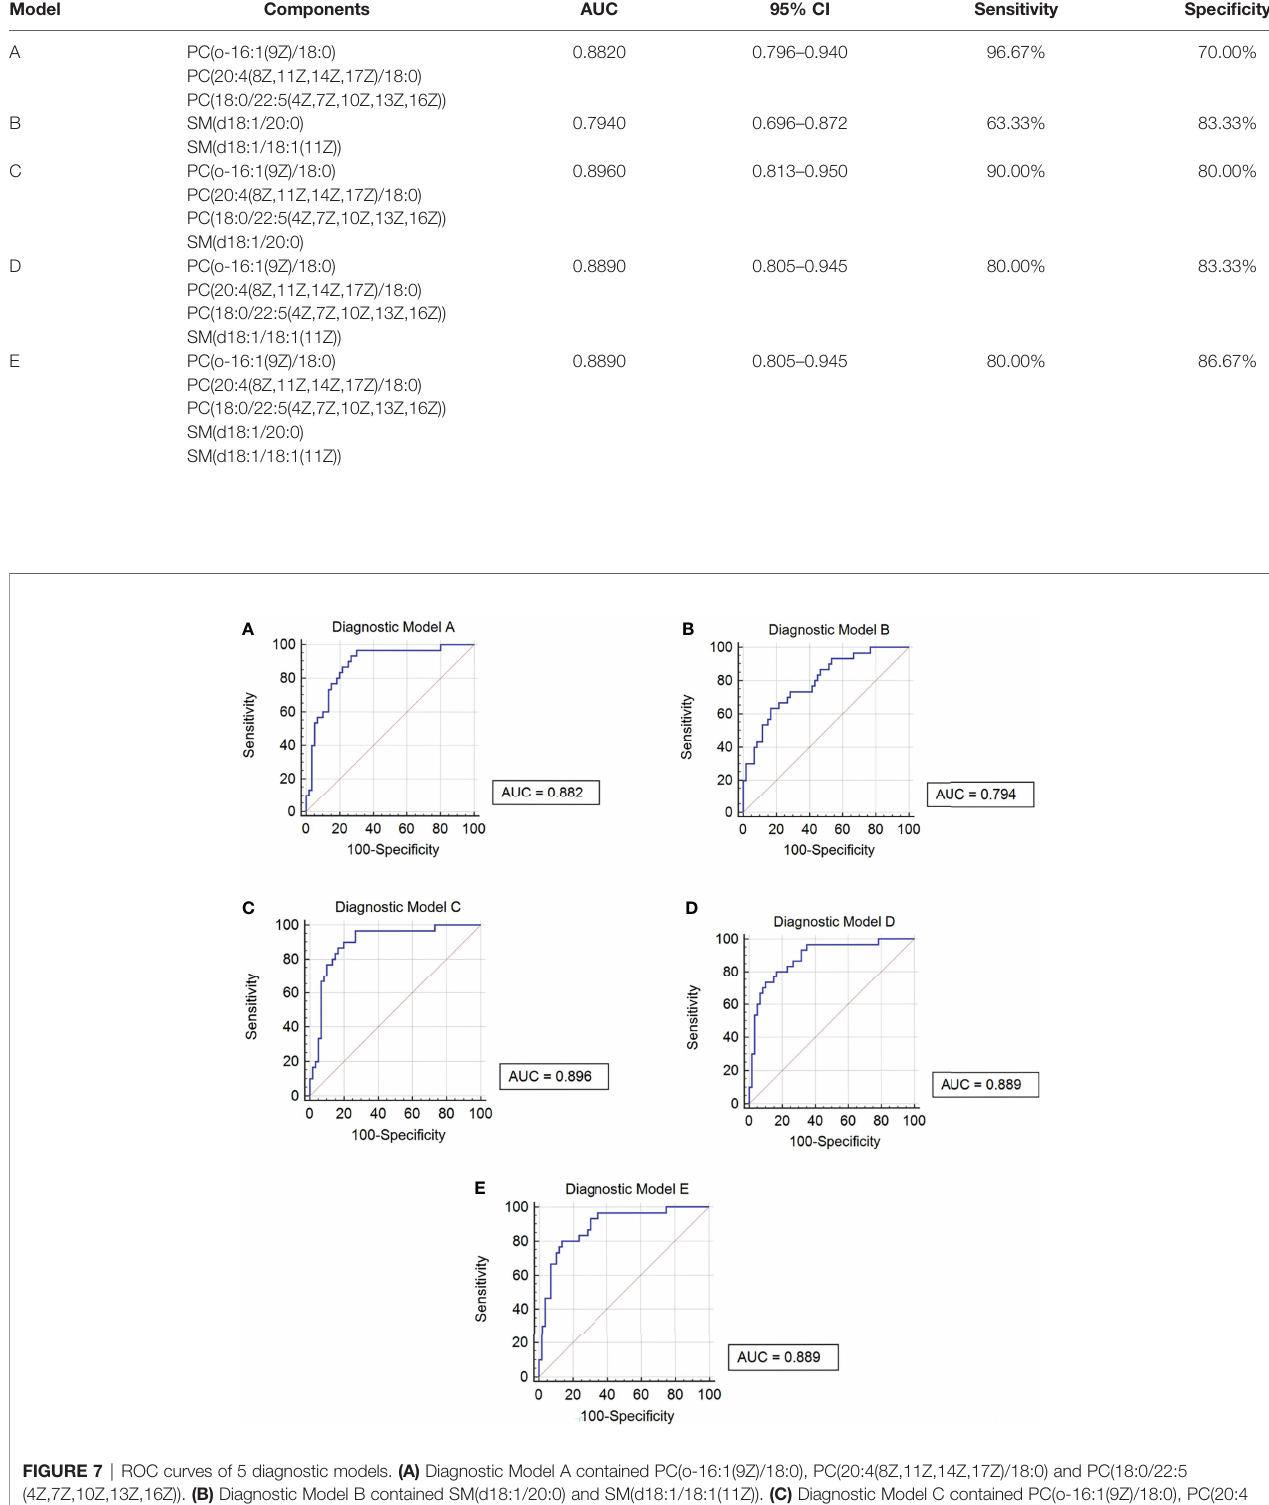
TABLE 5 | Diagnostic models based on fi ve upregulated potential metabolic biomarkers.